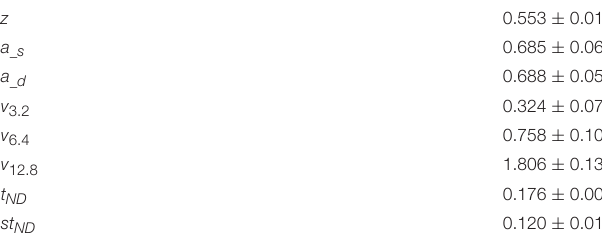
TABLE 4 | Fitted parameters (mean ± SE) of the fourth DDM (model a ).